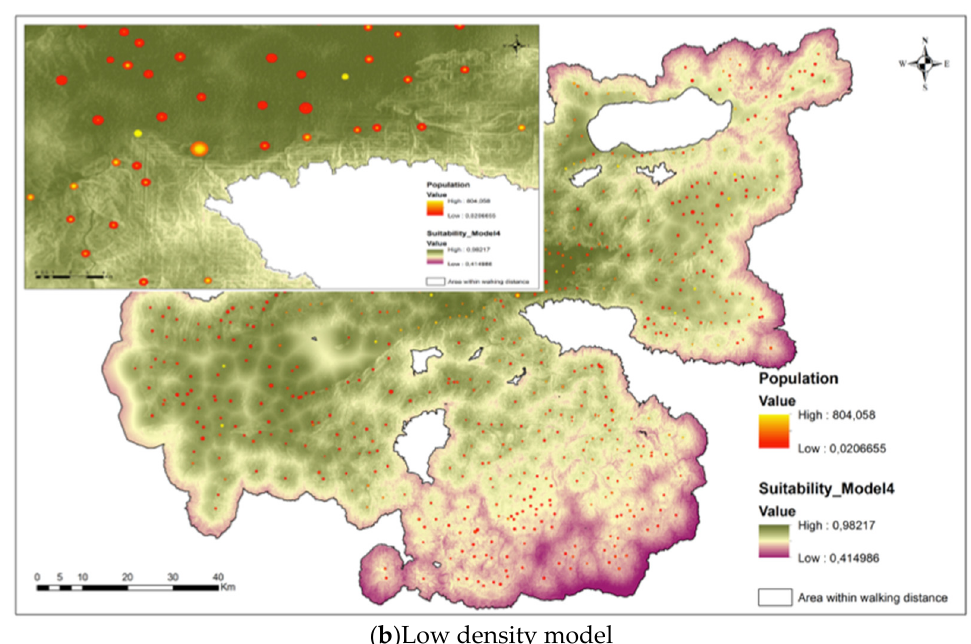
Figure 7. Population distribution maps. ( a ) High density model; ( b ) Low density model.